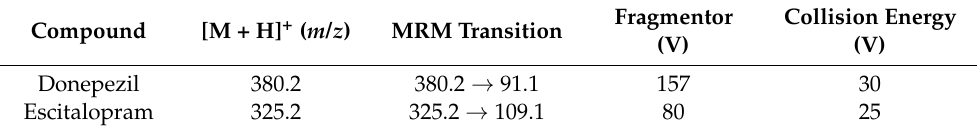
Fragmentor Collision Energy (V) (V)